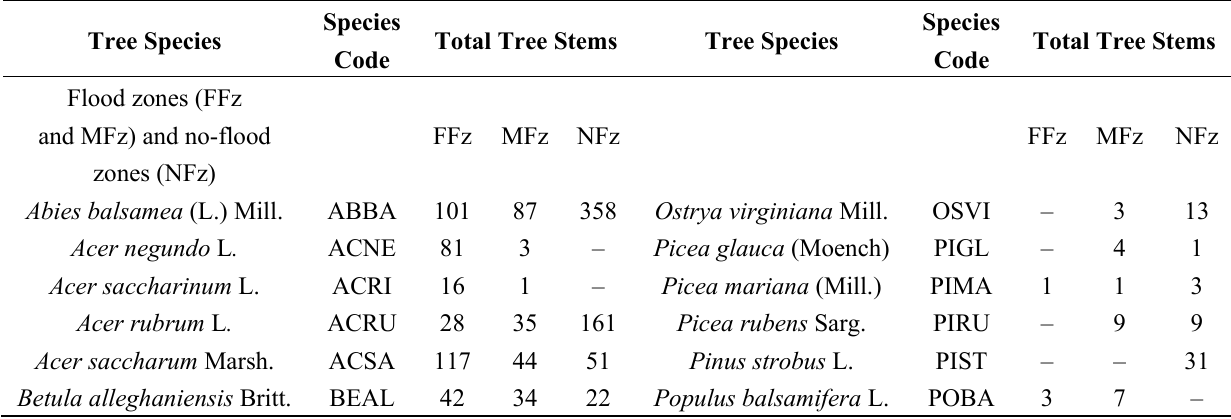
Table A1. All tree species identified in the 94 quadrats (10 m × 20 m) in the three zones (FFz, MFz and